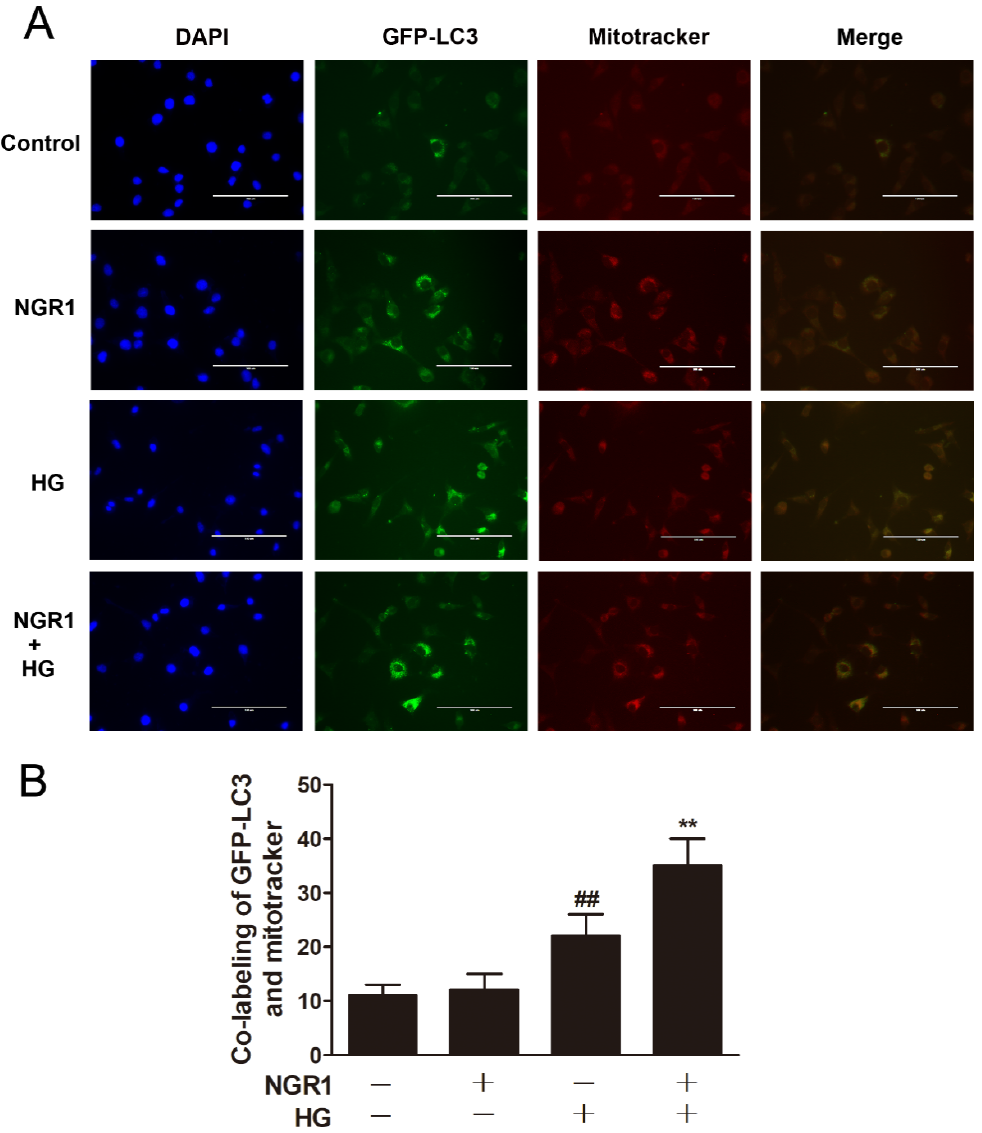
Figure 8. NGR1 pre ‐ treatment enhanced mitophagy in HG ‐ induced rMC1 cells. ( A ) rMC1 cells transiently transfected with the pCMV ‐ GFP ‐ LC3 expression vector were stained with MitoTracker ® Red CM ‐ H2XRos (Bar = 100 μ m). ( B ) Corresponding statistics of the GFP ‐ LC3 expression level. The results are expressed as the means ± SD (n = 5). Two groups were analysed by unpaired two ‐ tailed Student’s t tests, and multiple groups were analysed by one ‐ way analysis of variance (ANOVA); ## indicates a significant difference from control cells ( p < 0.01). ** indicates a significant difference from HG ‐ treated cells ( p < 0.01). (+), treatment with HG or NGR1; ( − ), treatment without HG or NGR1.